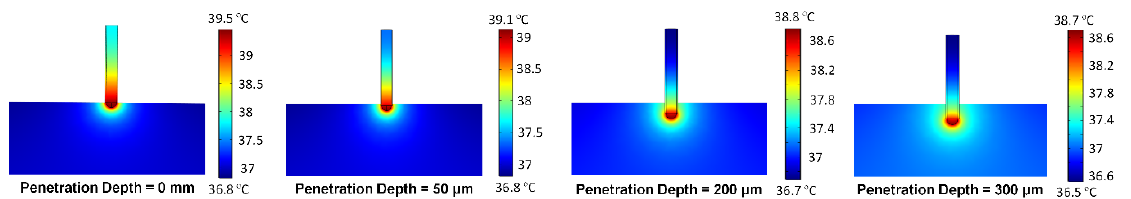
Electronics 2021 , 10 , x FOR PEER REVIEW